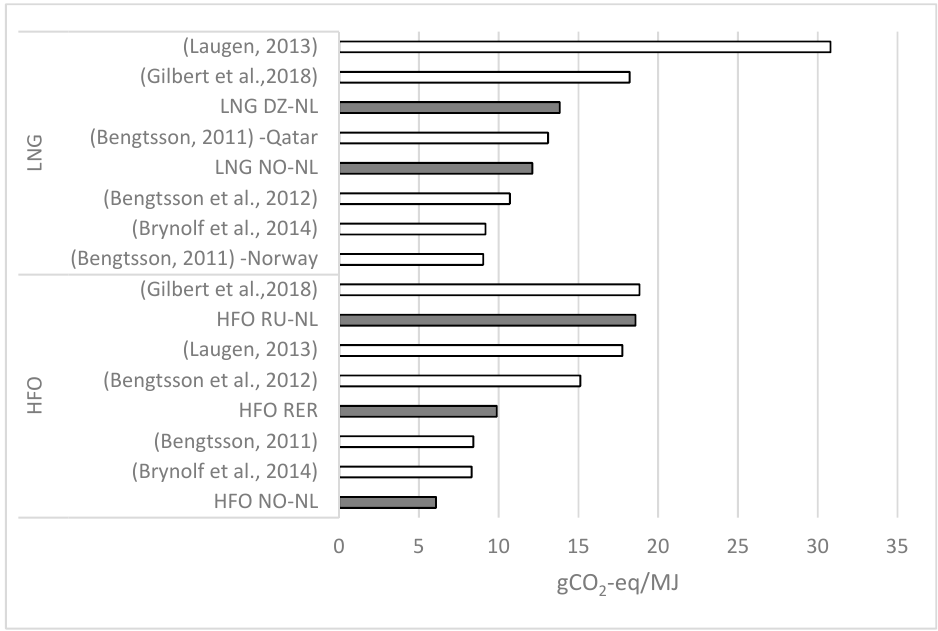
Figure 11. Comparison between results found in other literature and in the present study for the well-to-tank part of the system.